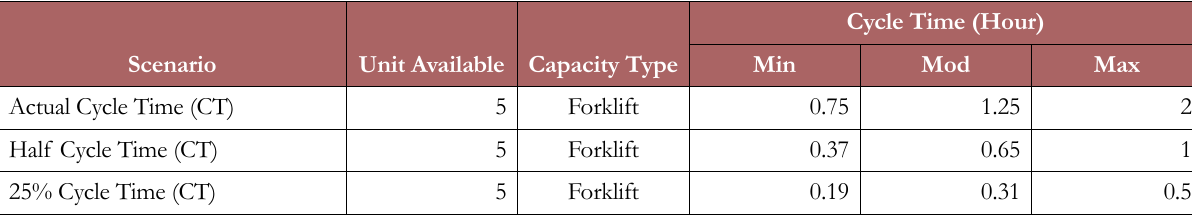
Table 2. Cycle Time of Transportation Process under Different Efficiency of Transportation